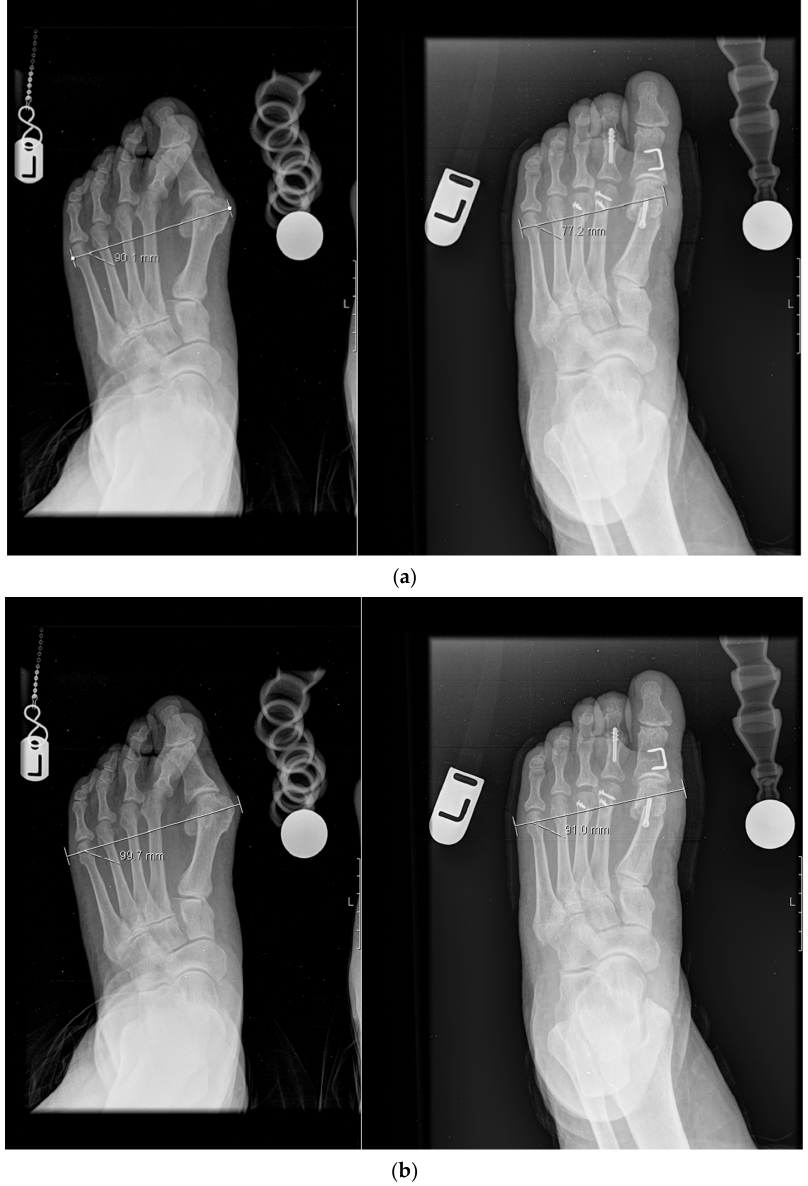
Figure 1. Pre and postoperative measurements of ( a ) BW and ( b ) STW on standing calibrated X-